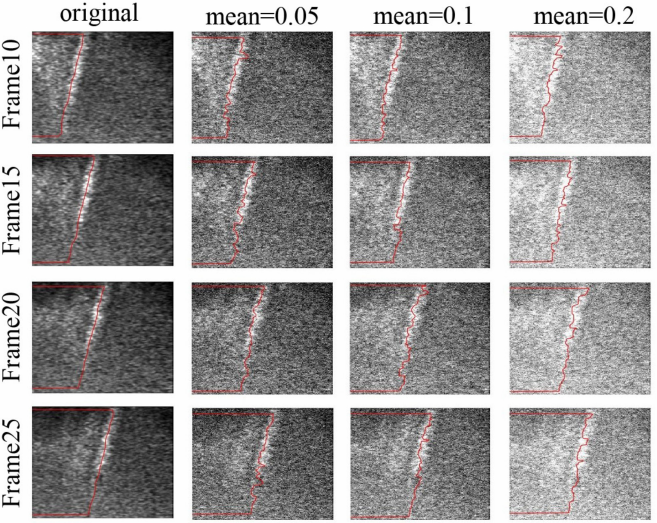
Figure 8. Gaussian noise experiment with equal noise standard